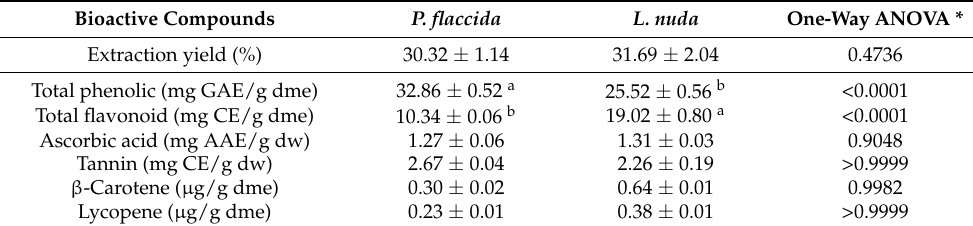
Table 1. Extraction yield and bioactive compound contents in the dried fruiting body of mush- room studies 1